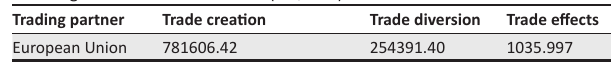
TABLE 2: Trade creation and trade diversion effects of the European Union Free Trade Agreement on South Africa (US$ 000). Trading